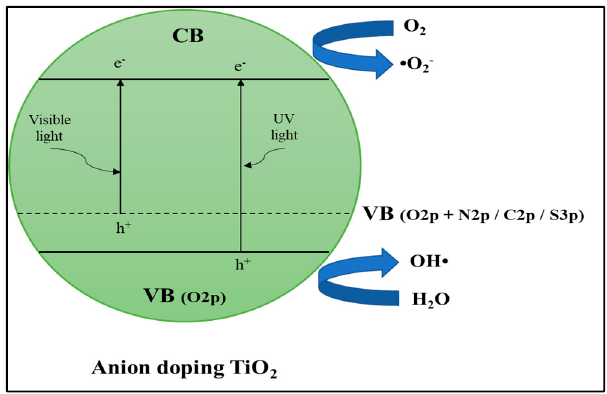
Figure 17. The schematic energy level of anion modified TiO 2 photocatalyst